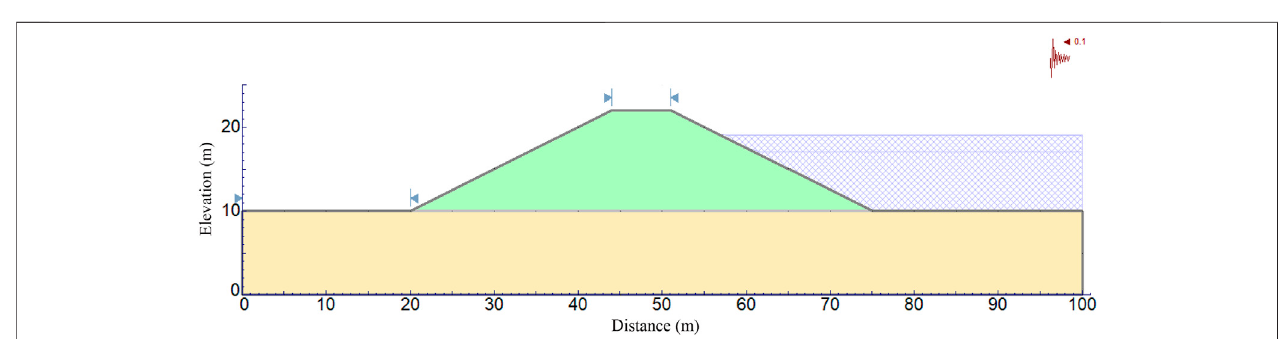
FIGURE 2 | Geometry and boundary conditions of the embankment example.